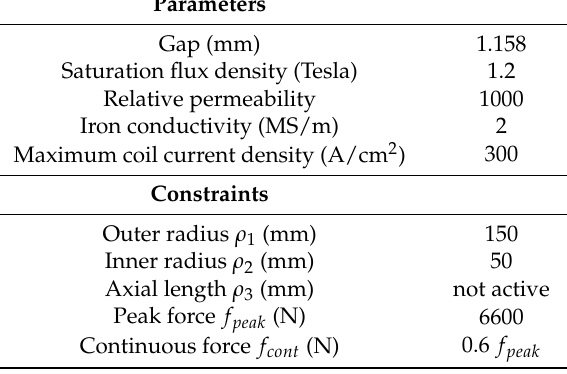
Table 2. Nominal values of parameters and constraints for design optimization.